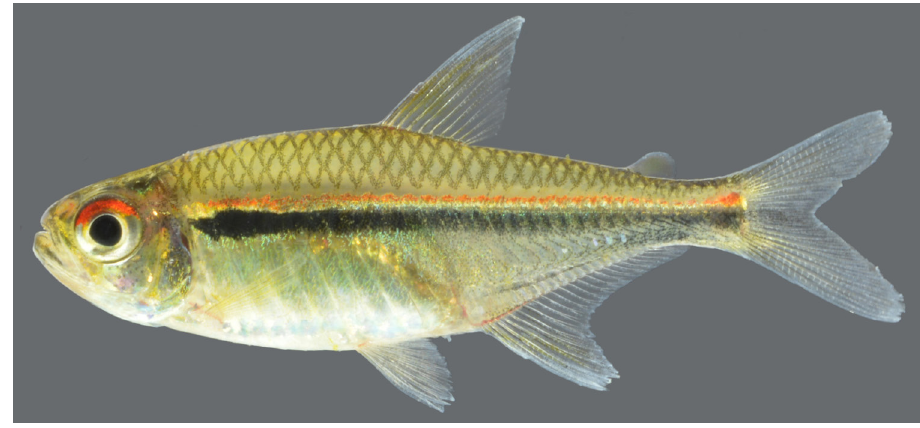
FIGURE 2 | Hyphessobrycon cantoi . Living specimen, Brazil, Pará, Santarém, stream tributary of lago Maicá (not